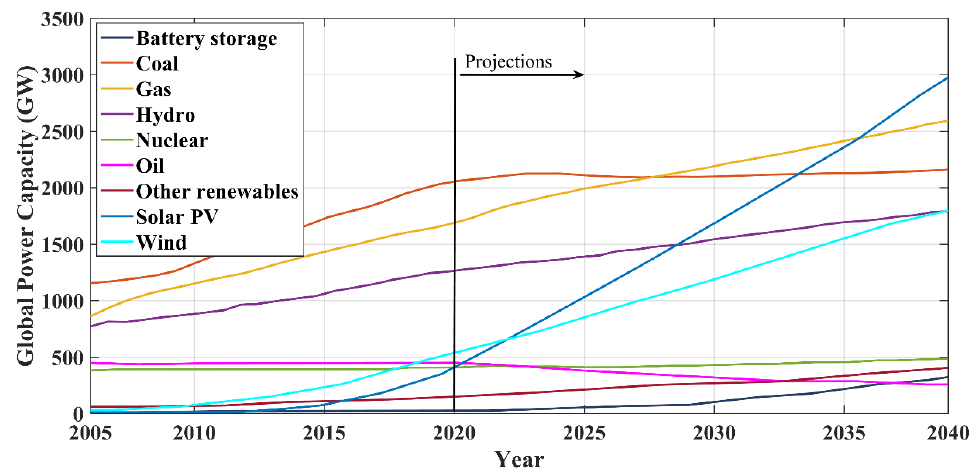
Figure 83. The prediction of global power capacity of different types of energy sources according to the World Energy Outlook 2019 (WEO2019).